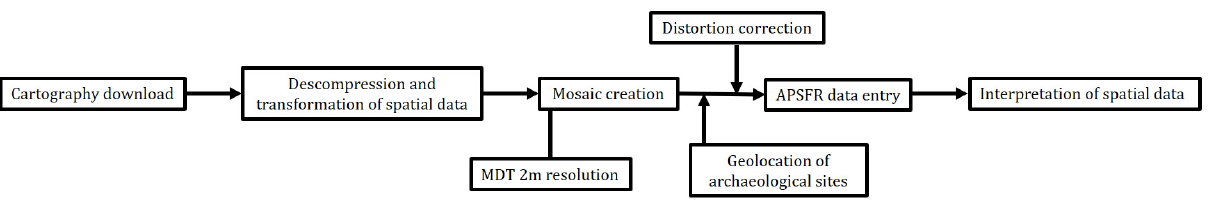
Figure 4. Workflow Figure 4. Workflow scheme.